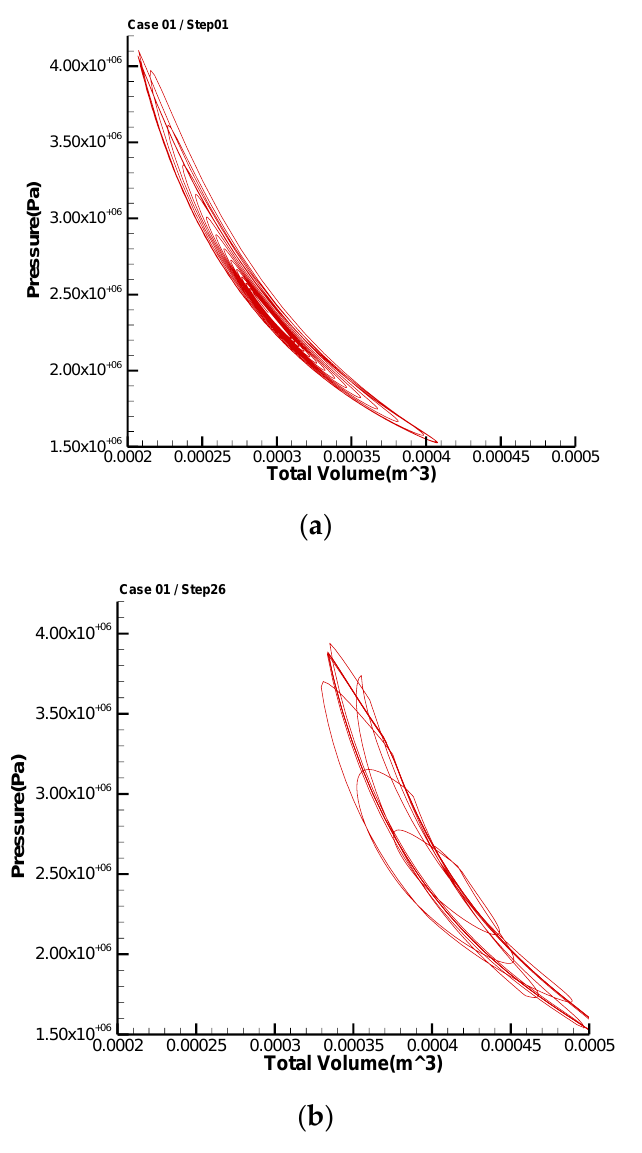
Figure 8. Comparison of the pressure – volume plots for Case 1: ( a ) initial design; ( b ) optimal design by the VSCGM. Table 3. Optimal design of Case 1.